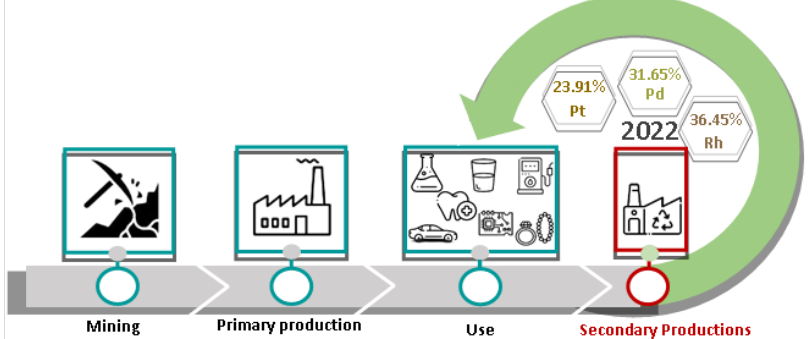
Figure 8. Contribution of PGM recycling to global demand for PGMs in 2022 (According to data from [49]).